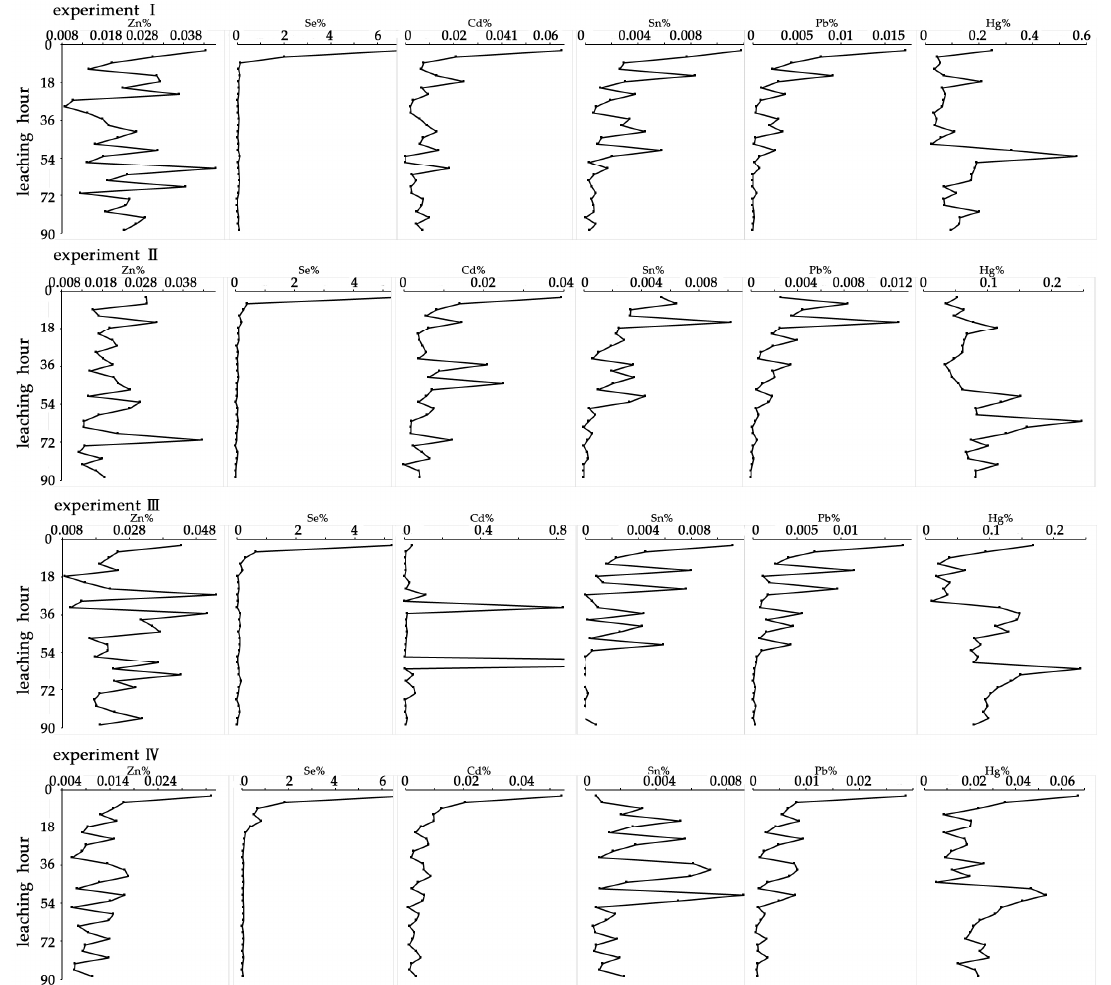
Figure 5. Leachabilities (%) of the elements Zn, Se, Cd, Sn, Pb and Hg from the coal gangue over 90 h in the four experiments.